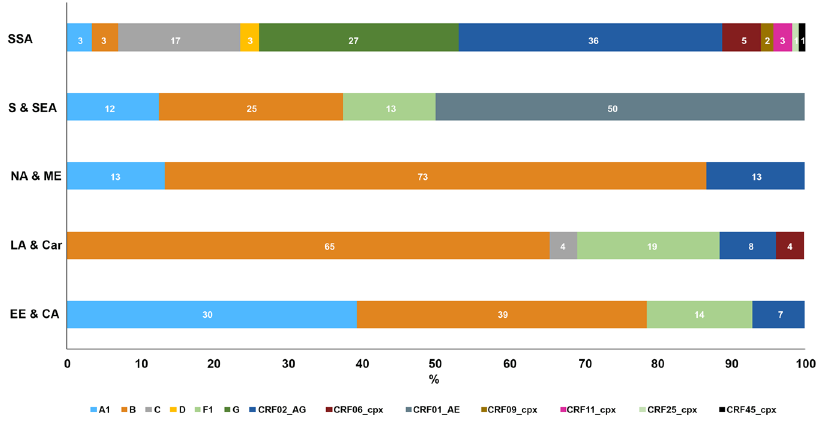
Figure 3. Distribution of HIV-1 subtypes and recombinant forms by geographical area of origin of 192 immigrants resident in Italy. Each subtype and CRF is identified by a colour according to the legend reported at the bottom of the figure. The prevalence of each genetic form is reported as the percentage of the total number for each